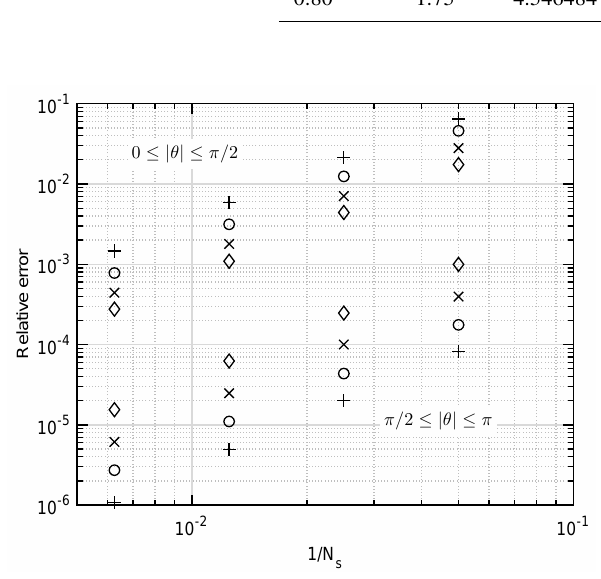
Figure 5. Angular contribution of straight segments to the influ- ence coefficient for z = 0 . 2, N s = 40, and θ 0 = 0. The value of θ is the midpoint of the segment. The solid line shows the numerical solution of the exact integral. shows the straight segment con- tribution, × the contribution from Eq. (17), and + the contribution (cid:51) from Eq.